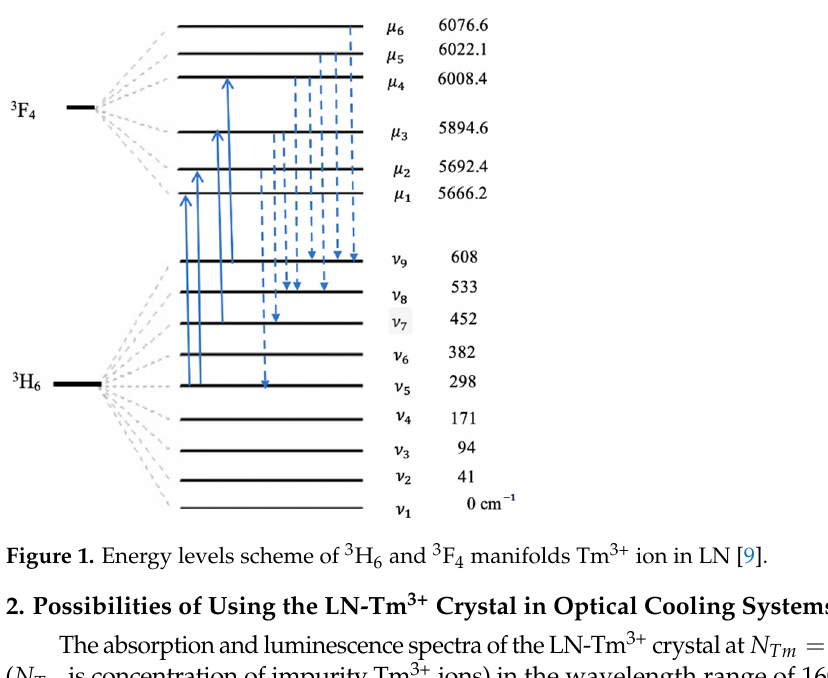
3 F 6 and 4 manifolds Tm